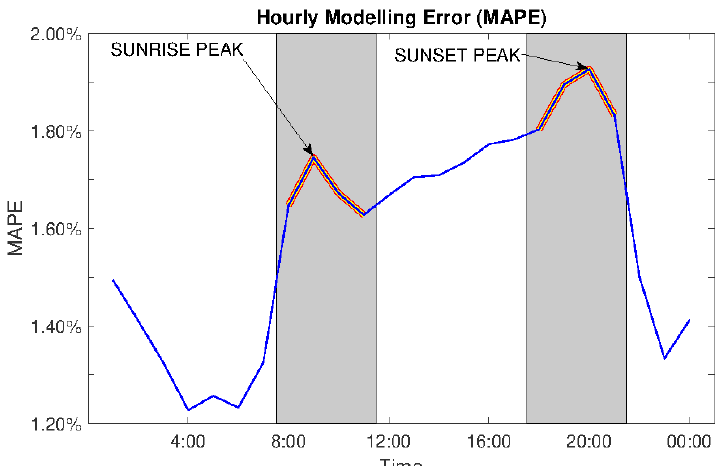
Figure 1. Average hourly error of the autoregressive model currently running at REE